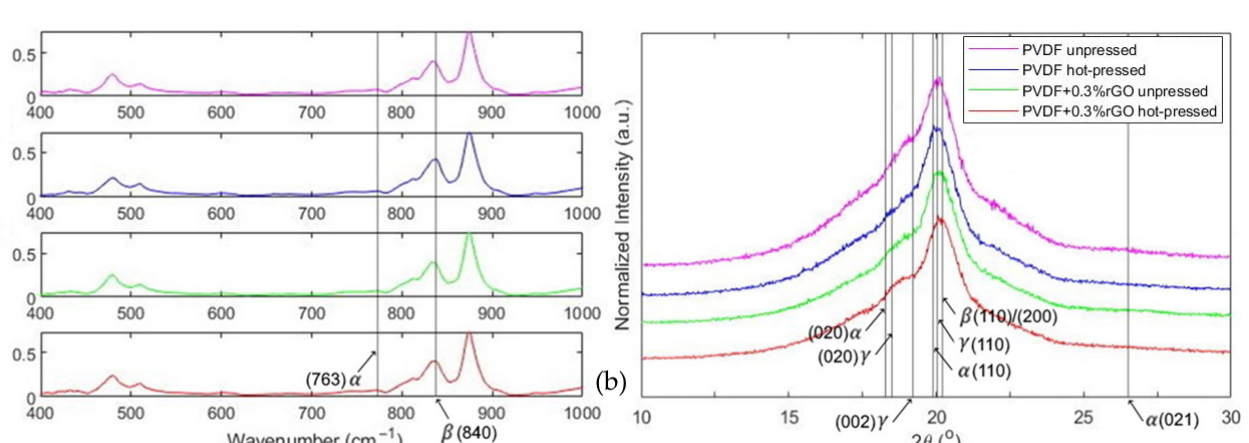
Figure 5. ( a ) FTIR-ATR absorbance spectrums; ( b ) X-ray diffraction spectrums.